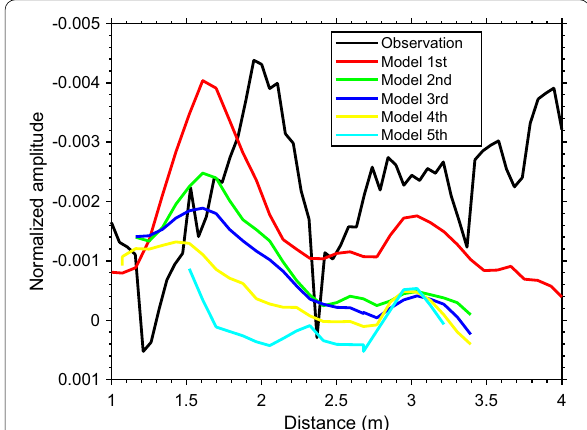
Fig. 5 Comparison of the normalized echo strength along the lower hyperbolic echo pattern between the observation and simulations in Fig. 4. The calculation method of the normalized echo strength is introduced in "Dielectric constant of the low-permittivity zone" section. The black, red, green, blue, yellow and cyan curves are the extracted normalized echo strengths for the observation (Fig. 4l) and the 1st to 5th models (Fig. 4), respectively